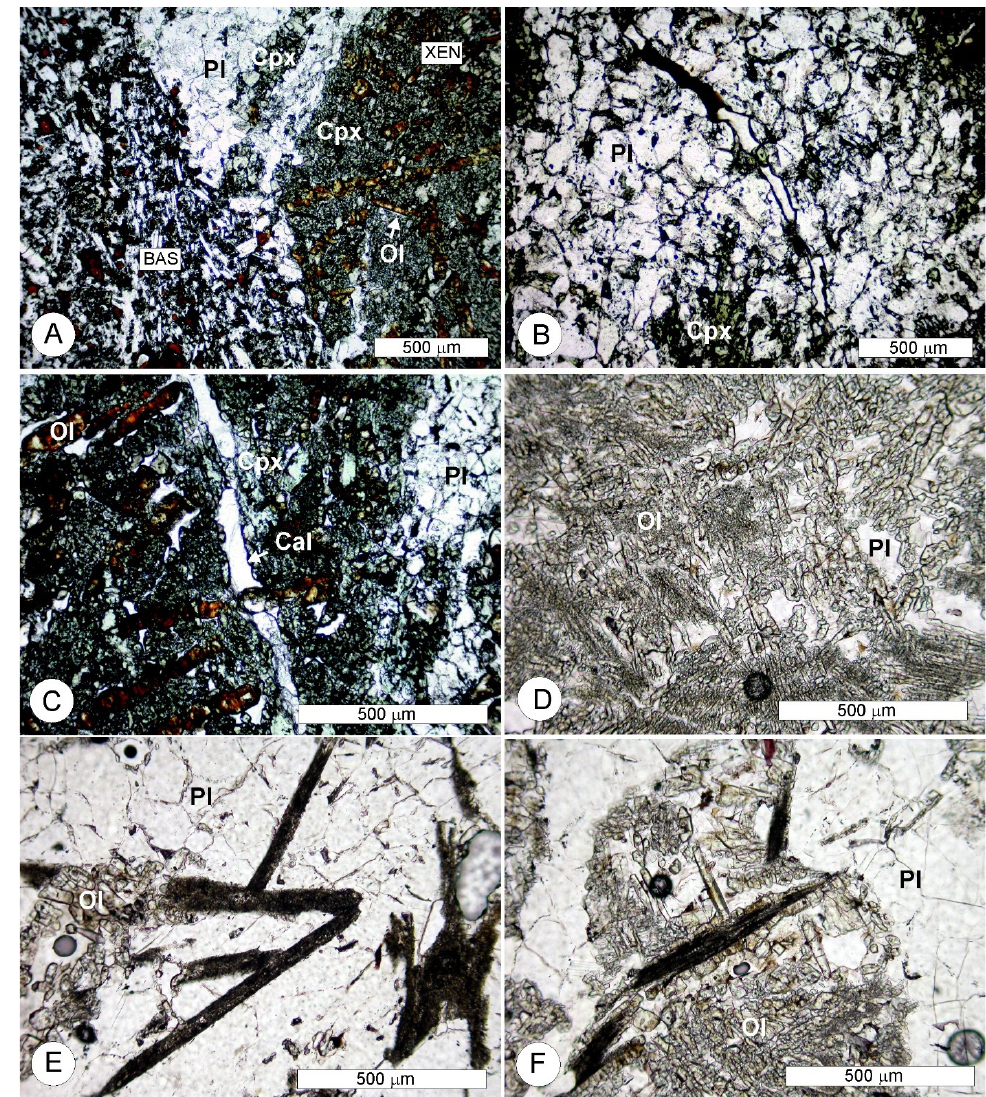
Figure 3. Photomicrographs of xenoliths in transmitted light: ( A ) Xenolith ‐ basalt interface. Sample Ca ‐ 14. BAS and XEN denote basalt and xenolith, respectively; ( B ) Plagioclase layer with disseminated clinopyroxene grains and clusters. Sample Ca ‐ 14; ( C ) Pyroxene ‐ rich layer with columnar olivine crystals growing across finely ‐ grained pyroxene and carbonate. Sample Ca ‐ 14; ( D ) Columnar olivine chaotically distributed in plagioclase groundmass. Sample Ca ‐ 22; ( E ) Opaque, randomly oriented pseudomorphs composed of spinel, olivine and plagioclase in coarse ‐ grained plagioclase layer. Sample Ca ‐ 22; ( F ) Pseudomorph epitaxially overgrown by columnar olivine crystals. Sample Ca ‐ 22. Mineral abbreviations in all photomicrographs after [29]: Ap—apatite, Cpx—clinopyroxene, Ol—olivine, Pl—plagioclase, Cal—calcite.